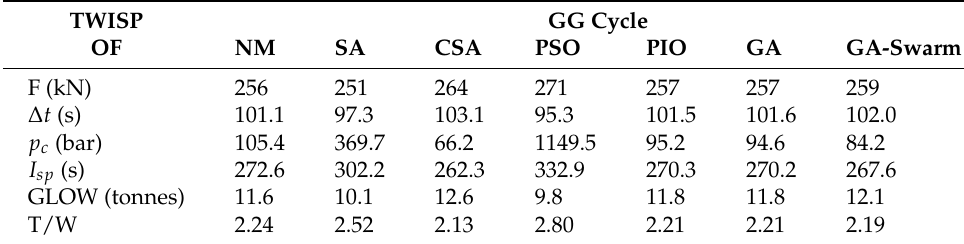
Table 7. GG Cycle: Values of Variables at max I sp and T/W for each